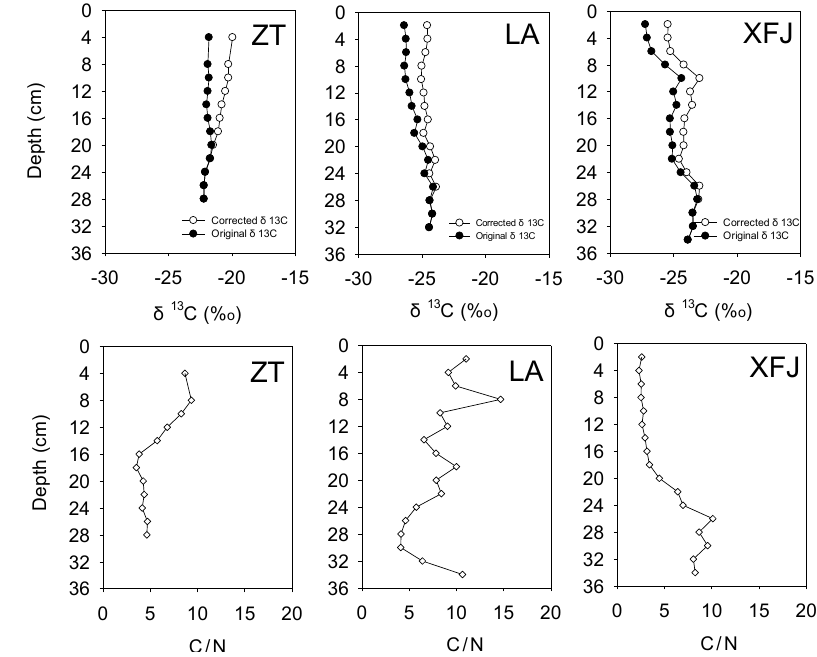
Figure 1. Vertical variations of original δ 13 C, corrected δ 13 C, and C / N in sediment cores of three